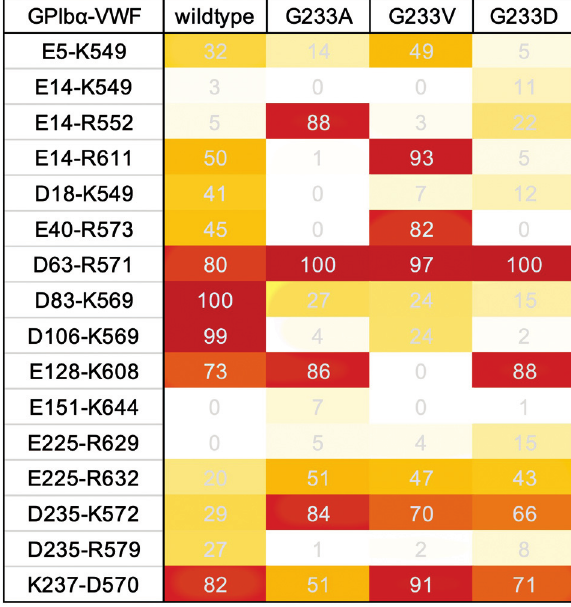
Fig. 5 Probability of the presence of salt bridges formed between VWF and GPIb ɑ . The probabilities of the presence of each pair of amino acid forming salt bridge are shown in the heat map. The pair of salt bridge formation more than 50% of calculation periods were shown with the color including red. The number of salt bridge formed more than 50% is apparently higher in wild-type and G233V mutant with VWF. The number of salt bridges is substantially lower in G233D